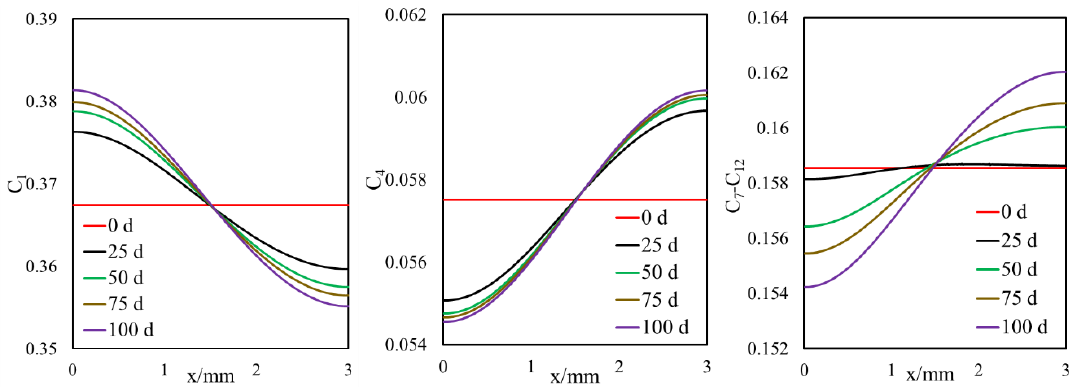
Figure 8. The overall composition of C 1 (left), C 4 (middle), C 7 -C 12 (right) at different times, Bakken shale oil.